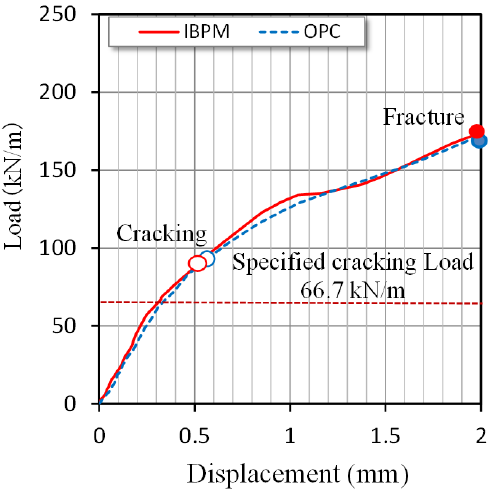
Figure 17. Road versus displacement relationship (box culvert).